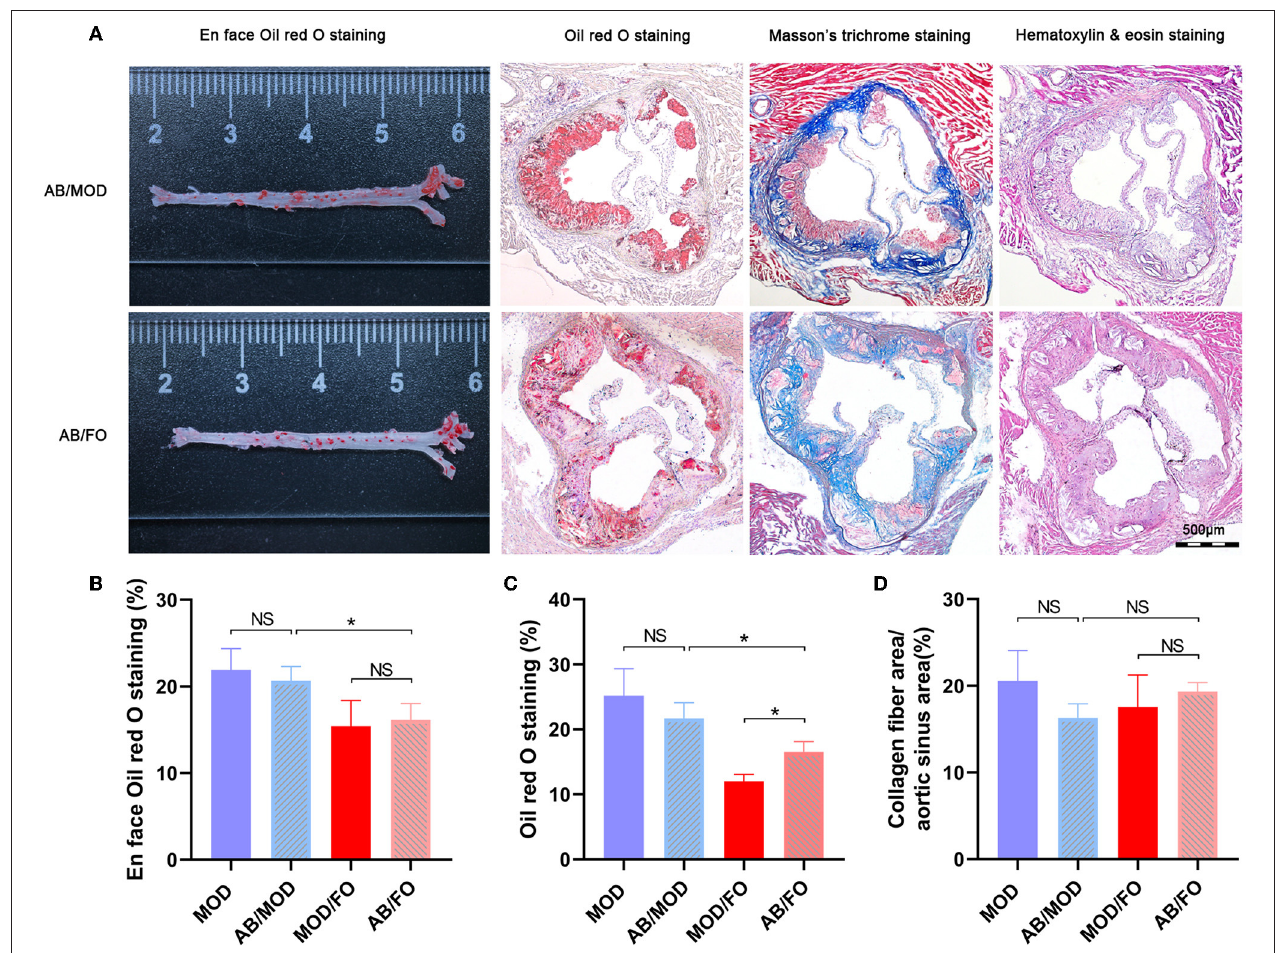
FIGURE 7 | Effects of dietary ALA-rich FO treatment on the pathological lesion in antibiotic (AB)-treated mice. (A) Representative sections of the valve area of the aorta and aortic root of the heart were stained with en face oil-red O staining, oil-red O staining, Masson’s trichrome staining, and Hematoxylin and eosin staining, respectively. Quantitative analysis as lesion area/total area (%) shown in oil-red O staining (B) , en face oil-red O staining (C) , and Masson’s trichrome staining (D) . * P < 0.05, NS, no significance. Original magnification, × 40. The bar of 500 µ m was presented in the right corner of (A) . All experiments were performed in